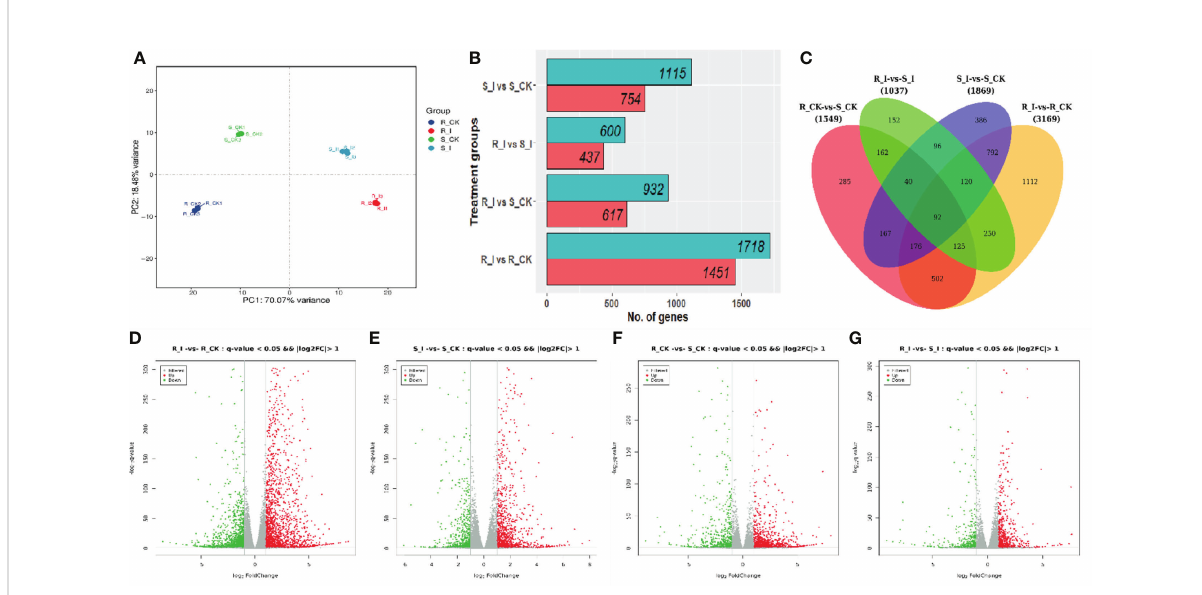
FIGURE 4 (A) Principal component analysis (PCA) of the replicated samples used for RNA-sequencing. All samples represented consistency in data among replicates. S/R_CK and S/R_I genotype factors showed variation among mock and diseases inoculated after 48 h. (B) Number of DEGs (p value < 0.005, statistically signi fi cant ≥ 2-fold), in different comparisons. (C) Venn graphs represent a cluster of DEGs from resistant and susceptible groups and interaction between the various treatment groups. (D – G) The volcano indicates the DEGs. Each dot in the fi gure signi fi es a particular gene. The green dot shows a signi fi cantly down-regulated gene, the red dot speci fi es a signi fi cantly up-regulated gene, and the dark grey dot is a group of non-signi fi cant differential